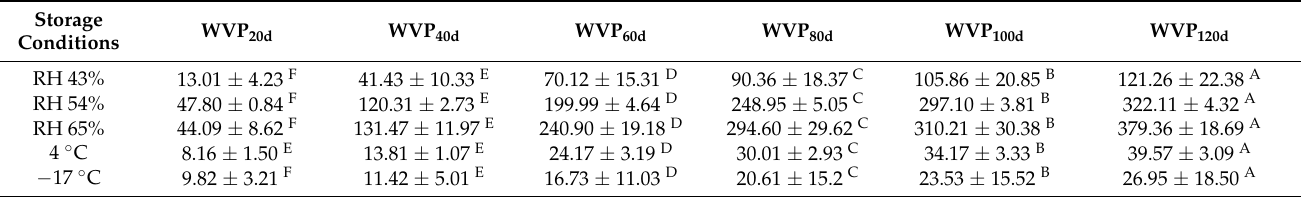
Table 5. The effect of storage conditions on water vapor permeability (WVP) of fish skin